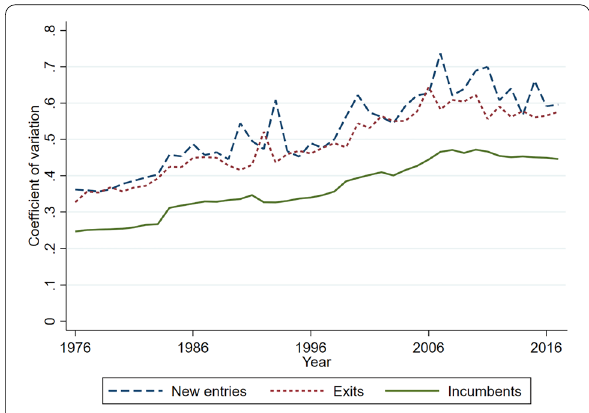
Fig. 10 Wage dispersion dynamics of entering, exiting and incumbent establishments, as measured by the coefficient of variation. Weighted by establishment